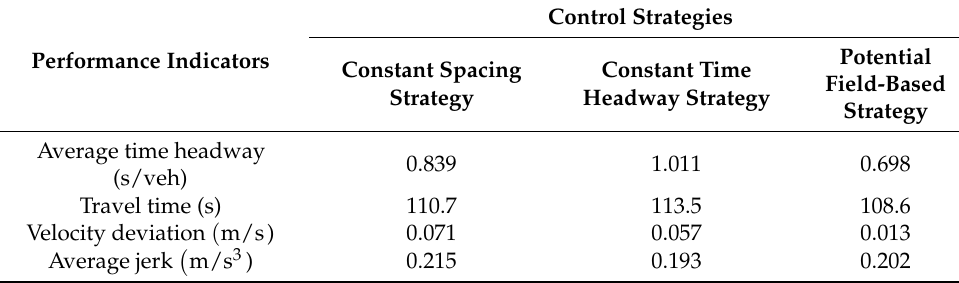
Table 3. Comprehensive performance for different control